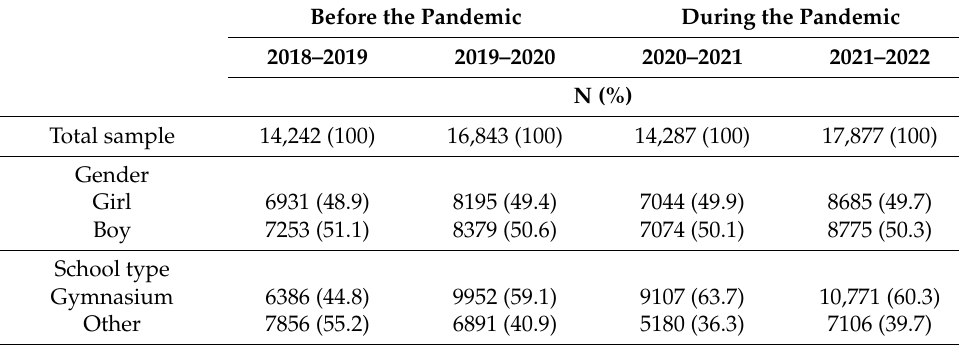
Table 1. Profile of each cross-sectional analysis sample from 2018–2019 to 2021–2022 of “Prävention- sradar”, by year. Before the Pandemic During the